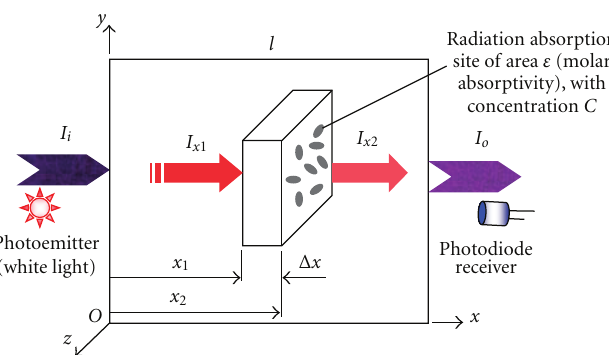
Figure 1: Model optical radiation passing through a hypothetical absorption medium.